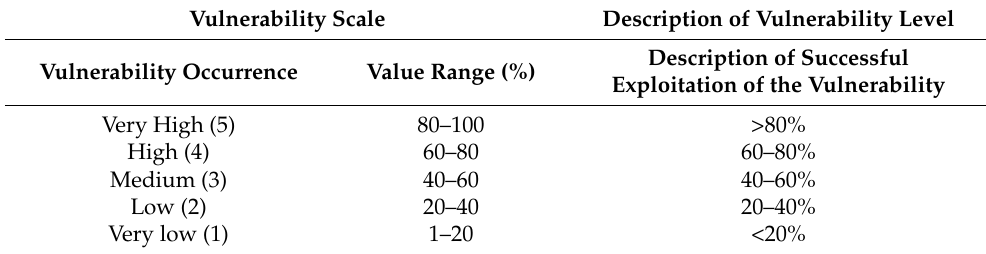
Table 1. Individual vulnerability assessment.